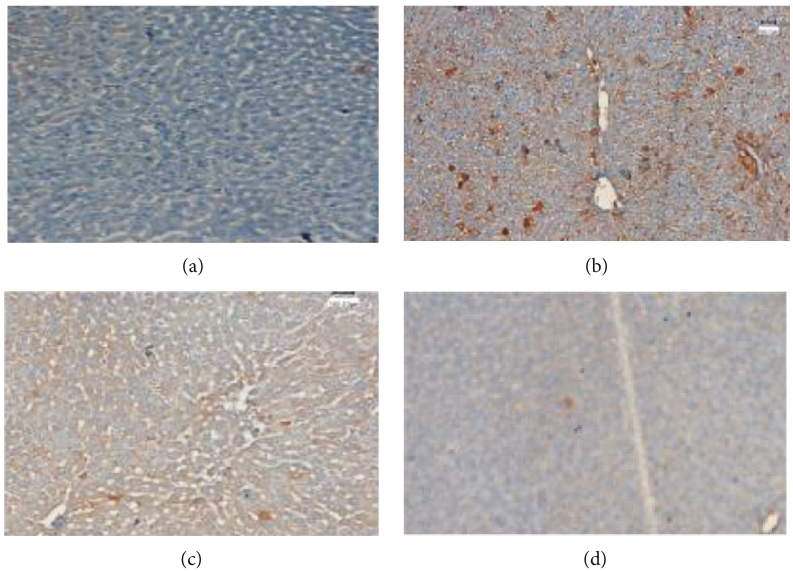
Figure 15: Immunohistochemical analysis of TNF- α . TNF- α protein expression was evaluated in di ff erent treatment groups (a – d). (a) The control group did not show any expression of TNF- α protein; (b) the DEN-treated group showed high expression of TNF- α protein; TNF- α expression was also noted in (c) rats treated with both DEN and 6-gingerol; and (d) 6-gingerol-only treated group did not shown any